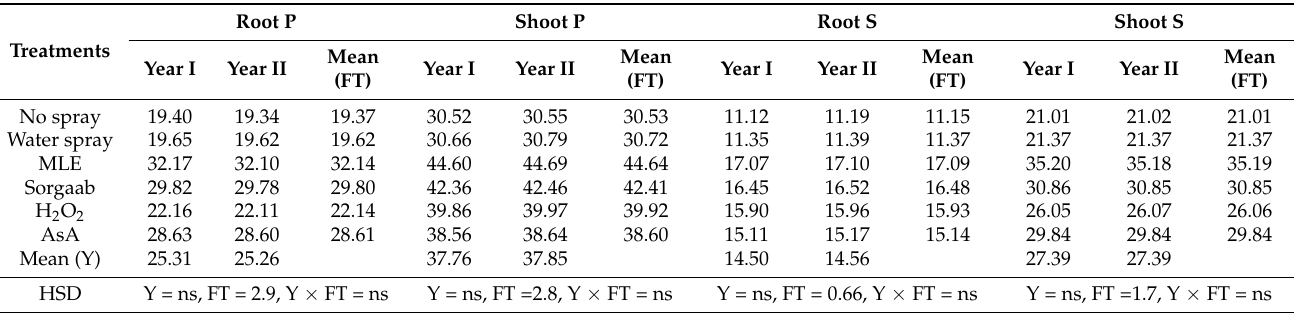
Means sharing the same letter did not differ significantly at p = 0.05. MLE = moringa leaf extract, AsA = ascorbic acid, Y = sowing year, FT = foliar treatments, Y × FT = interaction, ns =